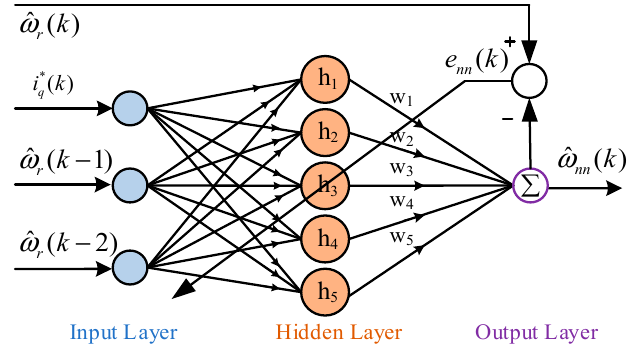
Figure 6. The structure of RBFNN (radial basis function neural network) in the NFC-based speed controller.